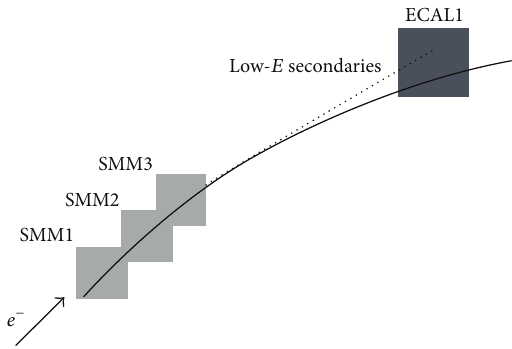
Figure 7: Track showing primary high energy missing the ECAL1 and the low energy secondaries hitting the ECAL1 which can be rejected from the hit point on SMM4 before the ECAL1 and the trajectory of the primary track in the first three Micromegas